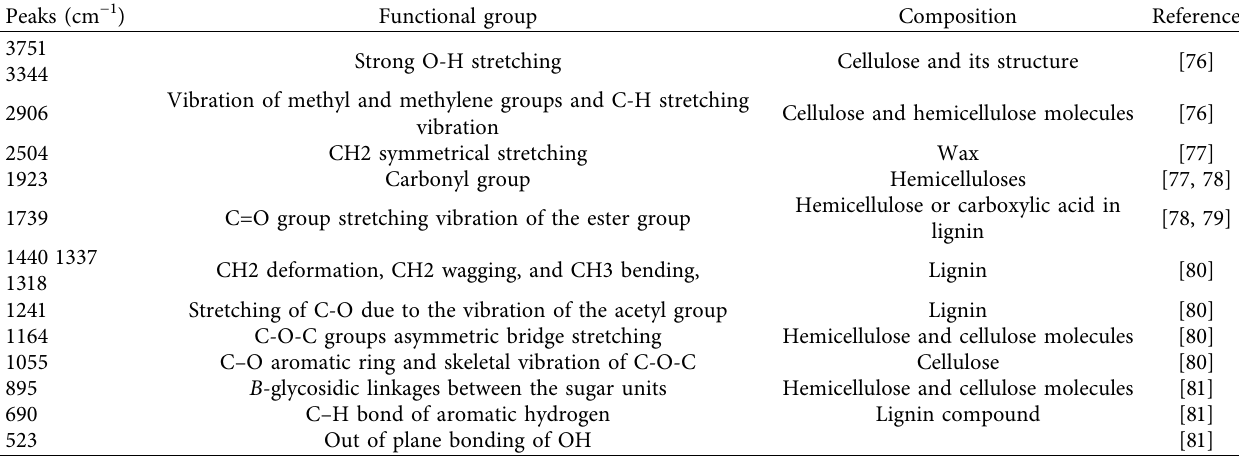
Table 6: Functional group analysis result with